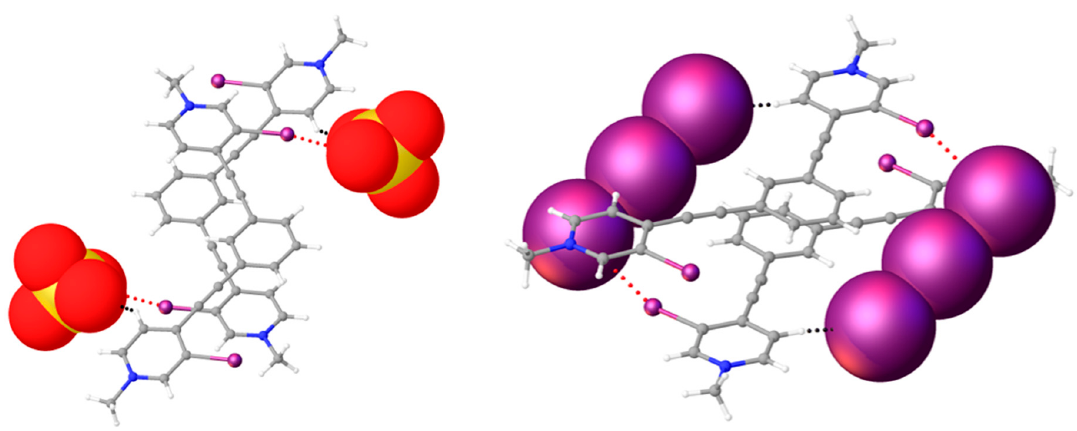
Figure 8. Diagrams of 2 ( left ) and previously reported triiodide complex [38] ( right ) highlighting anions that span the off-centered antiparallel dimers. These anions support the dimer formation through a combination of halogen bonding (red dotted line) and hydrogen bonding (black dotted line).